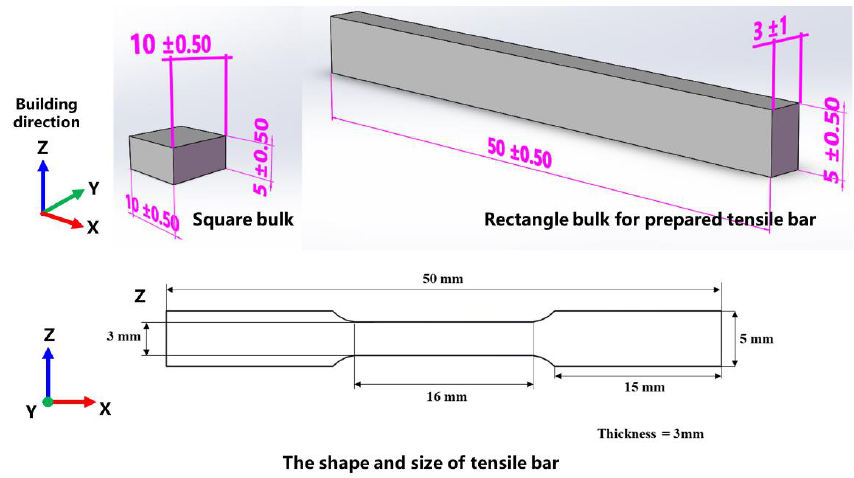
Figure 1. Design of bulk and tensile samples for LPBF built. Table 2. The LPBF parameters of Ti-Ta.